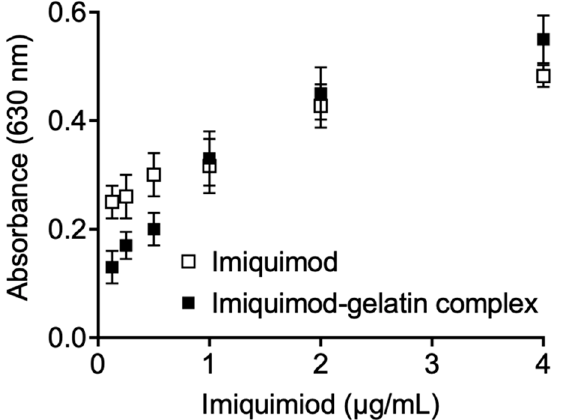
Figure 7. The effect of imiquimod and imiquimod-gelatin complex solution on immune response using RAW-BlueTM cell line. The induction of SEAP level was determined by measuring the samples’ absorbance at 630 nm.